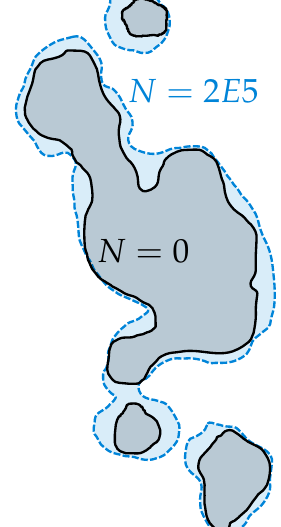
Figure 15. Representative XCT evaluated defects.